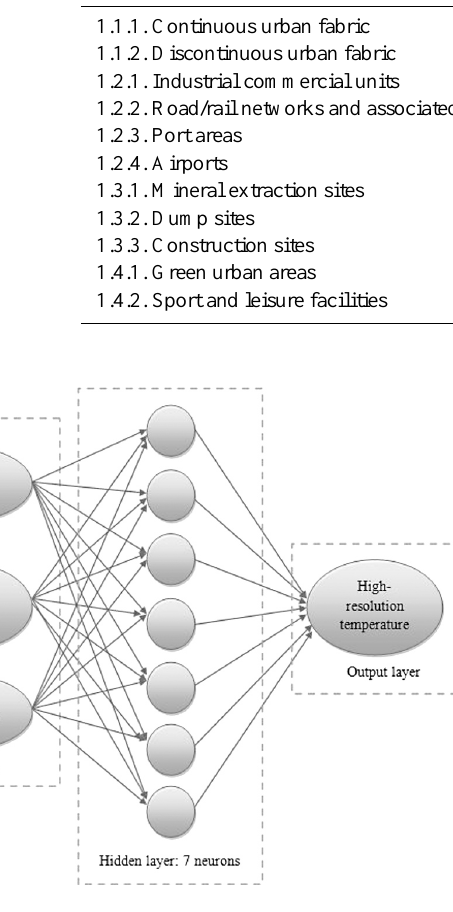
Fig. 4. Schematics diagram of the feed-forward neural network ar- chitecture.